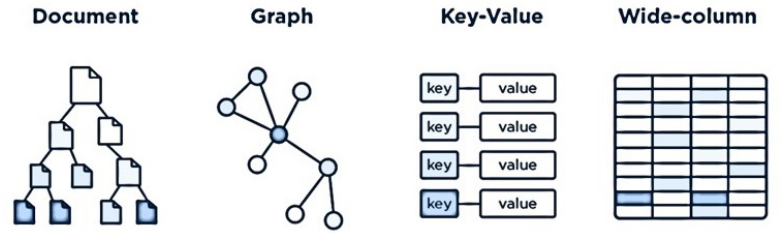
Figure 5. Storage structures used in NoSQL databases.